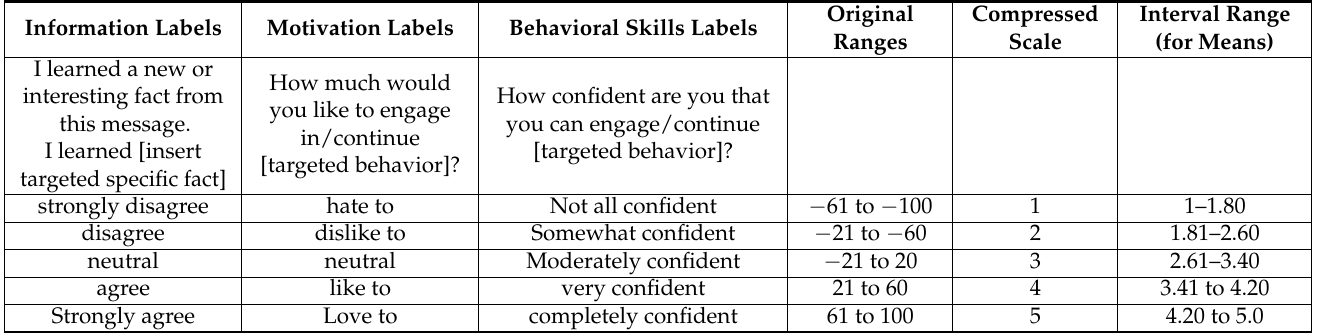
Table 2. Information, Motivation, behavioral skills (confidence) message response